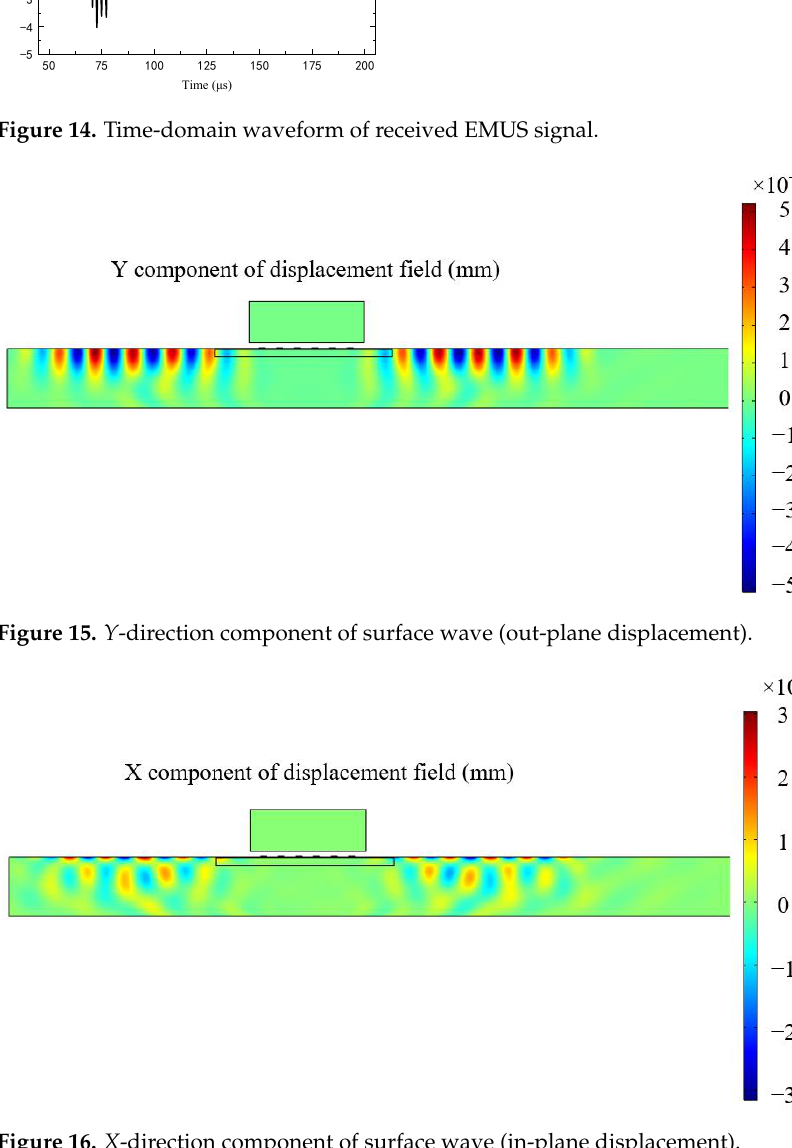
Figure 17. The resultant displacement of surface wave. 4. Results Analysis 4.1. Optimization of EMAT Excitation Parameters The main factors affecting the amplitude of EMUS surface wave are magnetic field, excitation current, and coil parameters. The magnetic field and excitation current are positively correlated with the amplitude of the surface wave. The magnetic field and excitation current is usually set to the maximum according to the external conditions. Therefore, this section mainly studies the influence of coil parameters on surface wave amplitude. As shown in Figure 18, the coil parameters include coil thickness, width, and lift-off distance. According to the common specifications of EMAT in aluminum plate and current coil manufacturing level, the value range of each factor can be determined in Table 1. The three parameters affect each other. To determine the optimal coil parameter combination, 4 3 tests are required, which requires a huge amount of calculation. To obtain the optimal coil parameter combination and analyze the influence of each parameter individually on surface wave amplitude, this study adopted the orthogonal experiment method to optimize the coil parameters. Orthogonal experimental design is a design method for studying multi-factors and multi-levels. Some representative points